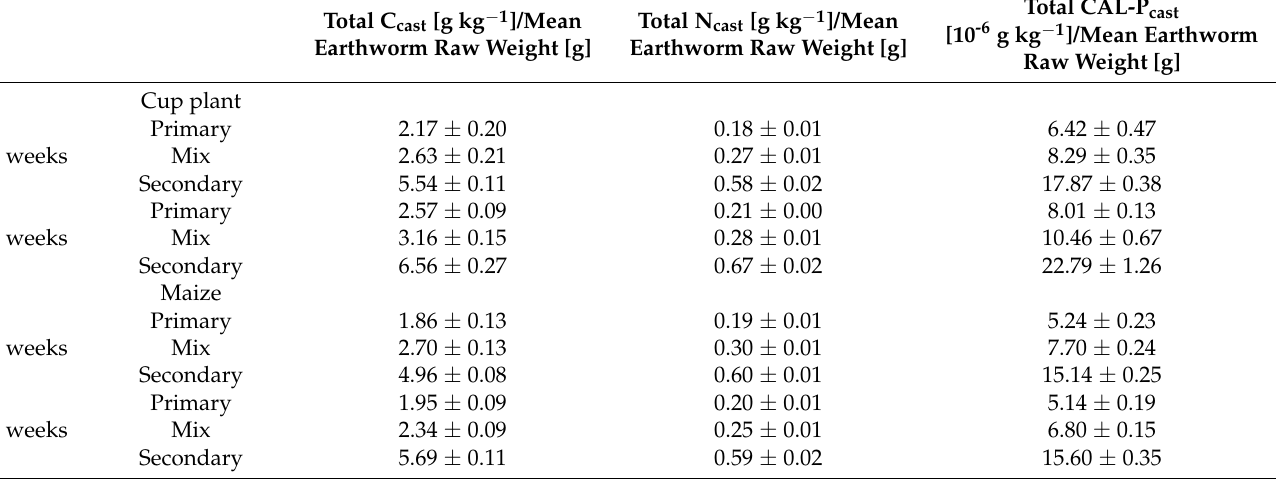
Table 4. Total C cast , total N cast [g kg − 1 ] and total CAL-P cast [10 − 6 g kg − 1 ] in casts per mean earthworm biomass [g] (means ± SE, n = 5) in cup plant and maize treatments for 4 and 8 weeks of incubation for earthworm treatments. Primary = primary decomposer L. terrestris ; secondary = secondary decomposers A. caliginosa and A. rosea ; mix = primary and secondary decomposers. For statistics see Figures S2–S4 and Table S5 of the Supplementary